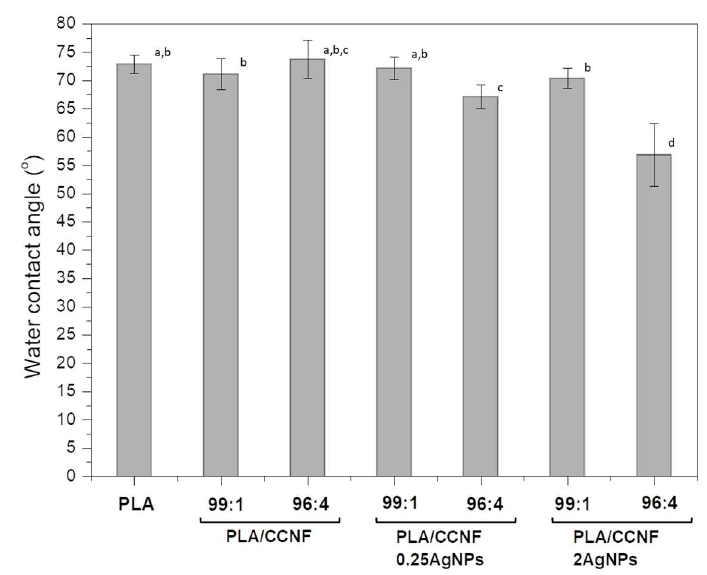
Figure 4. Water contact angles obtained for neat PLA and PLA reinforced with CCNF, CCNF/0.25AgNPs, and CCNF/2AgNPs films. Different letters (a–d) indicate significant differences (p < 0.05).